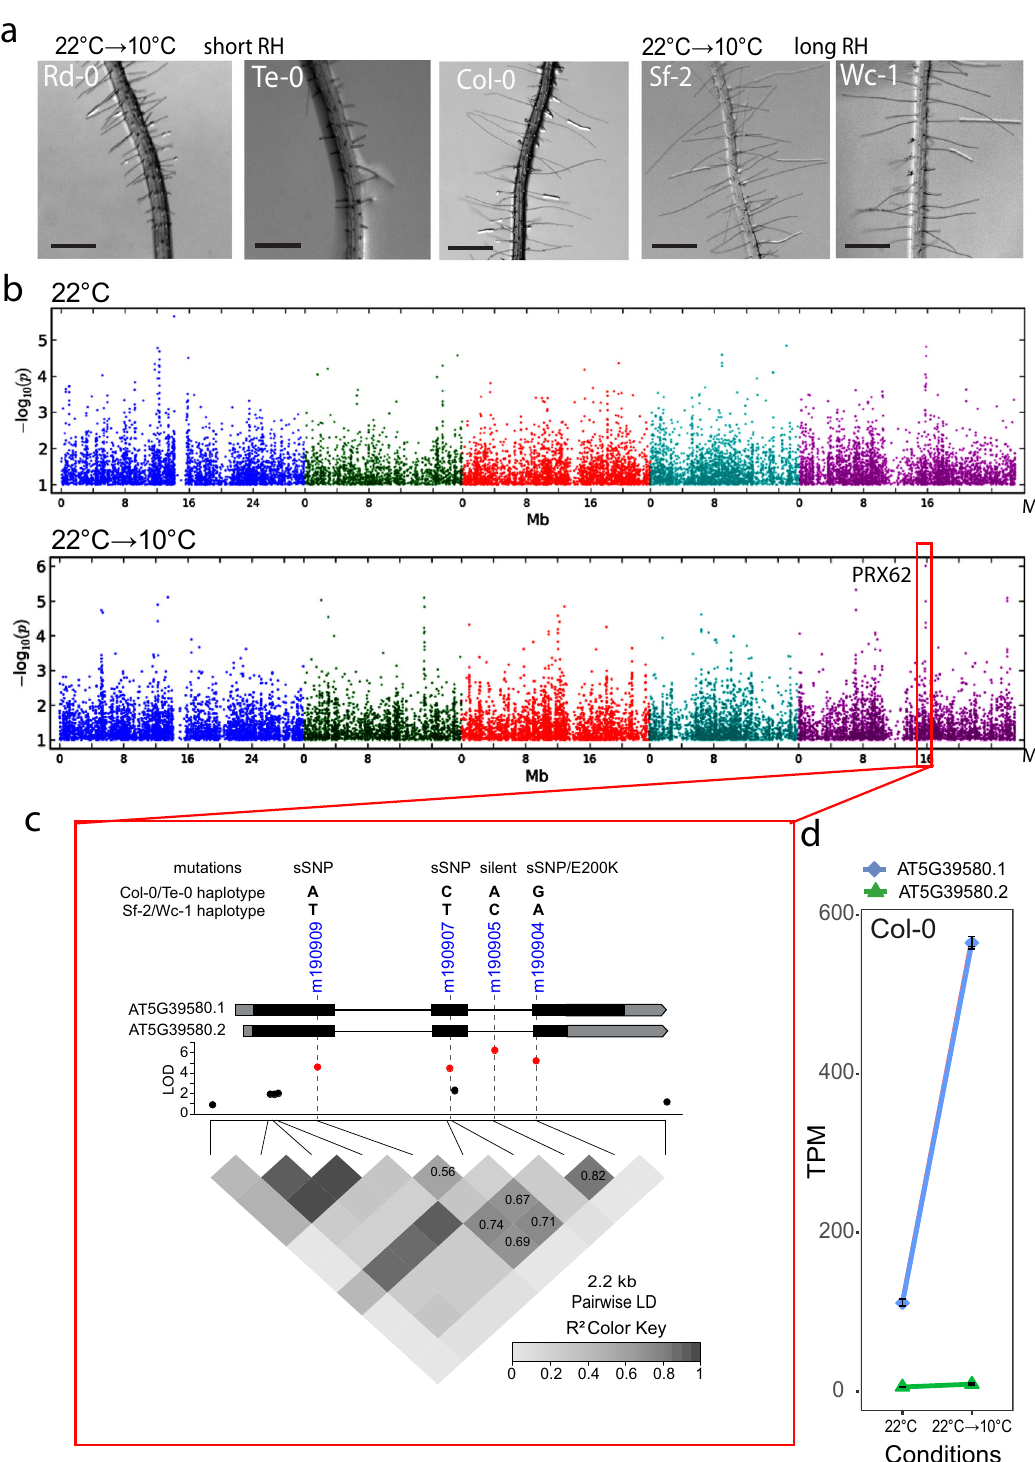
Only the full-length transcript of PRX62 (AT5G39580.1) is detectable in Col-0 and it increased up to 2.54 log 2 FC in roots exposed to low temperature (RNA-seq